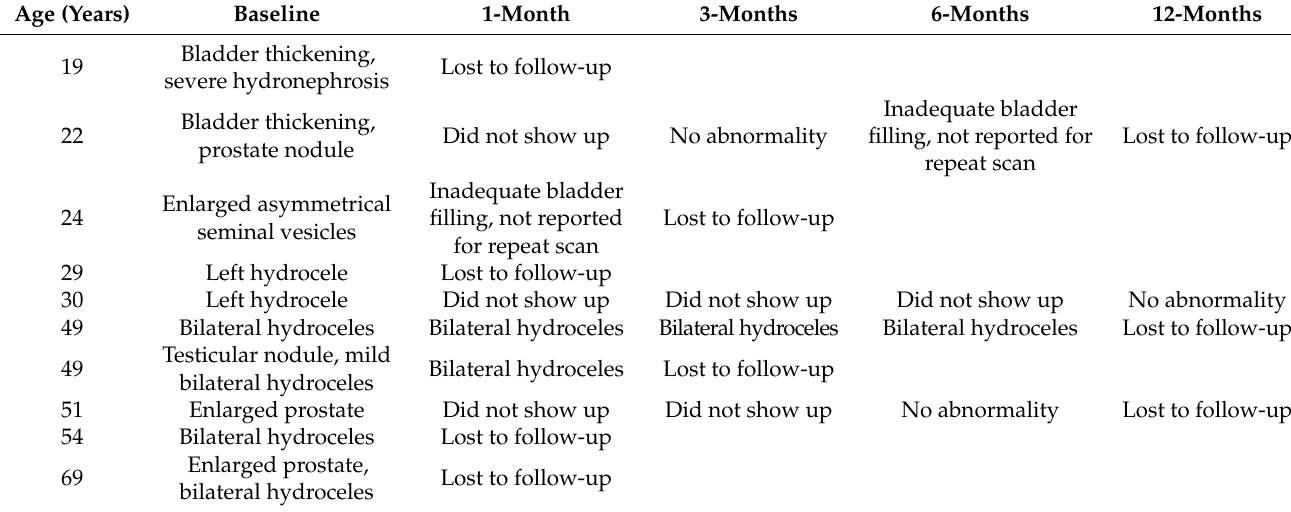
Table A1. Ten participants with abnormalities in Pelvic organs (9 in genital organs) on ultrasonogra- phy at baseline and progression over the time points in the study.